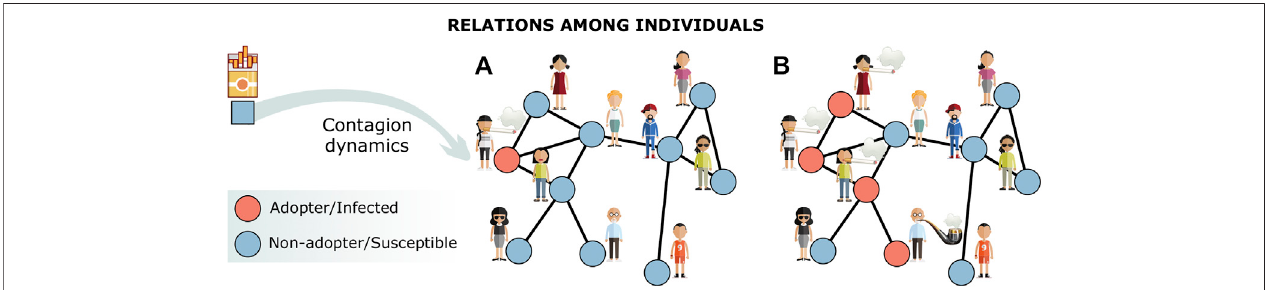
FIGURE1| Illustration ofacontagion process. Theadoption ofnorms,behaviors,ideas,technologicalitems, etc. istypicallymodeled asaspreading processover a networkof social contacts. Red and blue nodes of the social network denote, respectively, the adopters (or infected individuals) and the non-adopters (or susceptible) of the item that is spreading. For example, in (A) , a smoker transmits the — bad — habit to its neighboring agents, which in turn can transmit it again through their social links (B) .